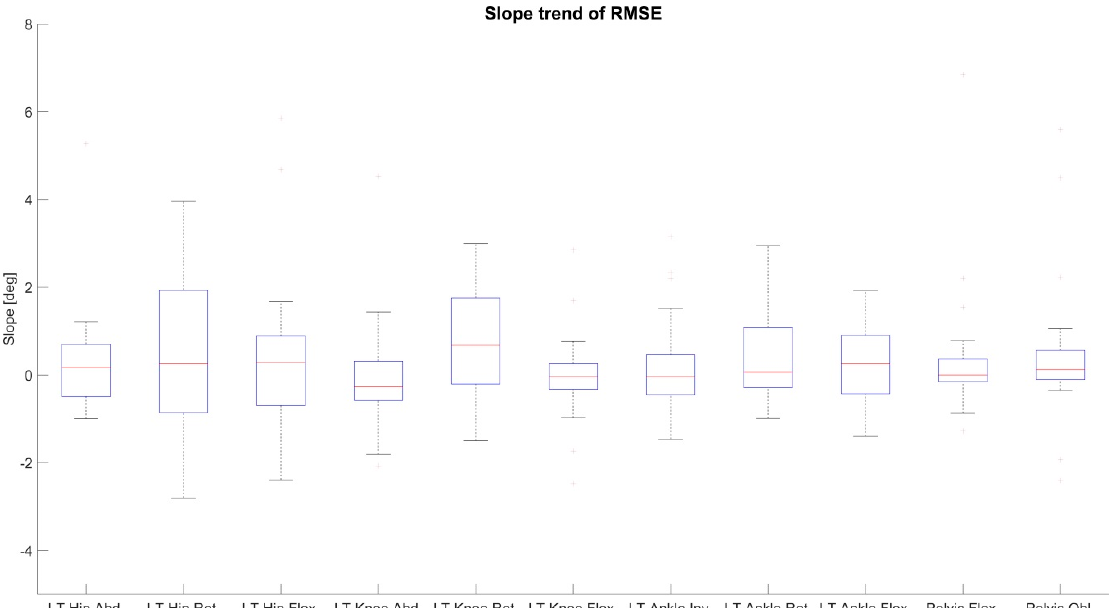
Figure 6. Evaluation of linear regression of RMSE for condition 2 over time exemplary for the left lower extremity and global pelvis angles in sagittal and frontal plane. On the vertical axis is the slope of the regression line in degree. Median slope values, quartiles, and whiskers are above and below zero indicating no increasing trend of RMSE over time.